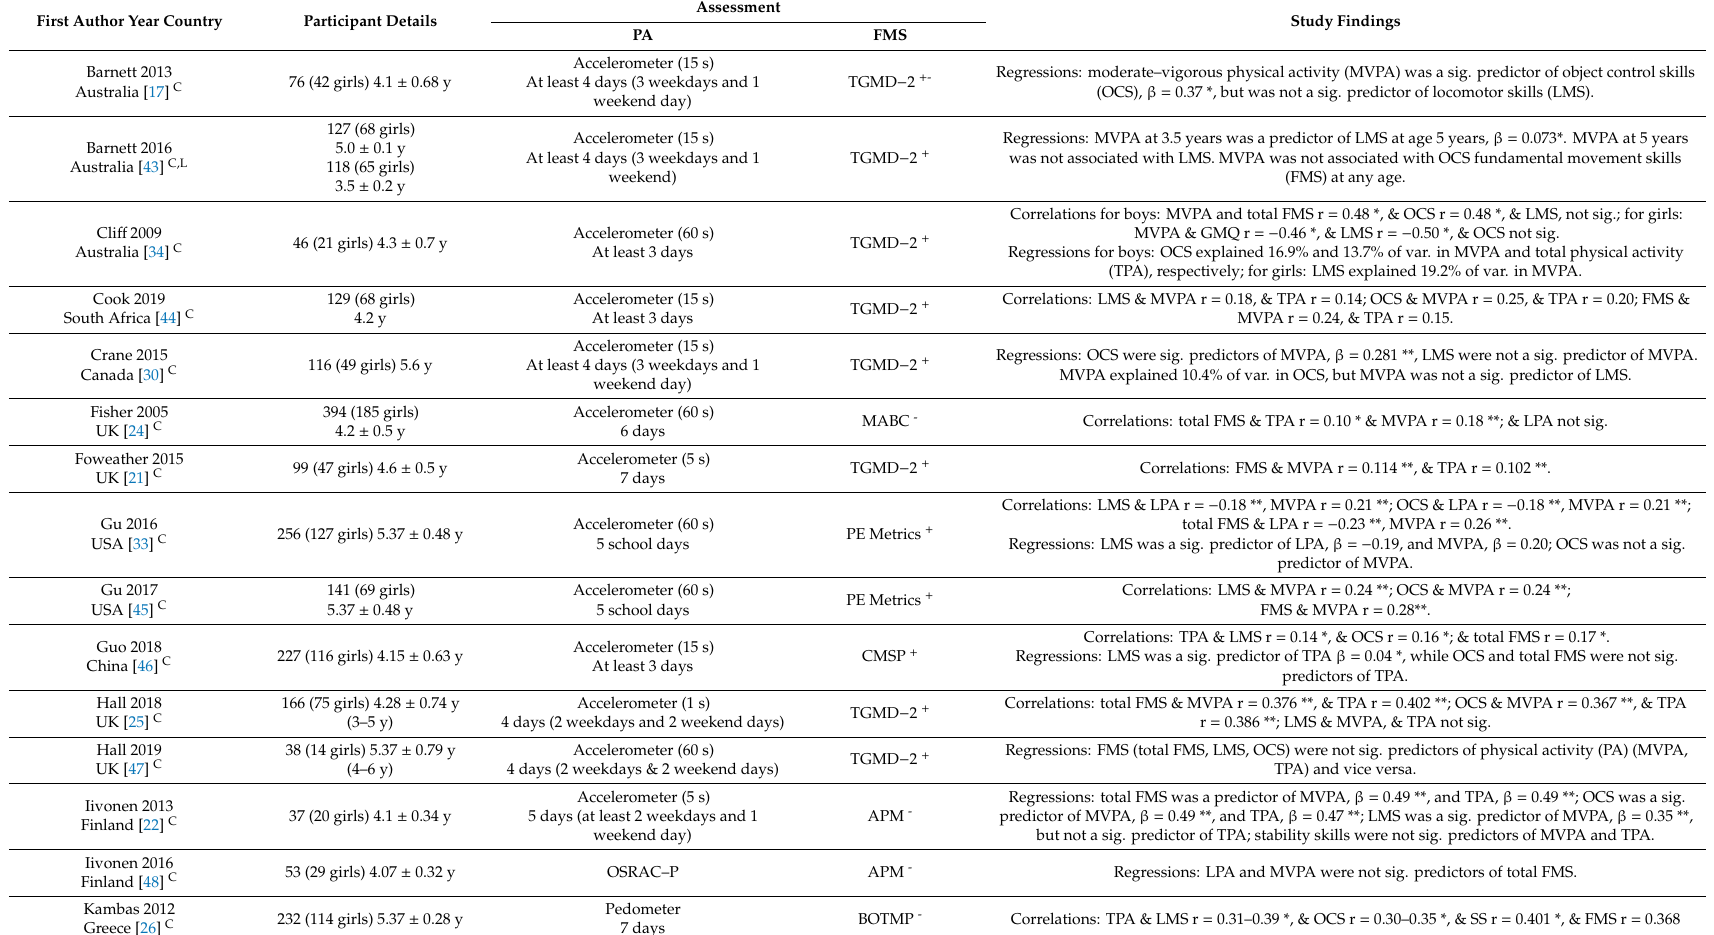
Table 1. General characteristics of the studies included in the systematic review.